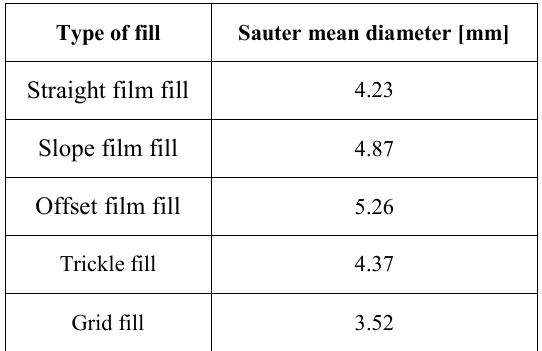
Fig. 9. Histogram of droplets diameters under film fill offset .